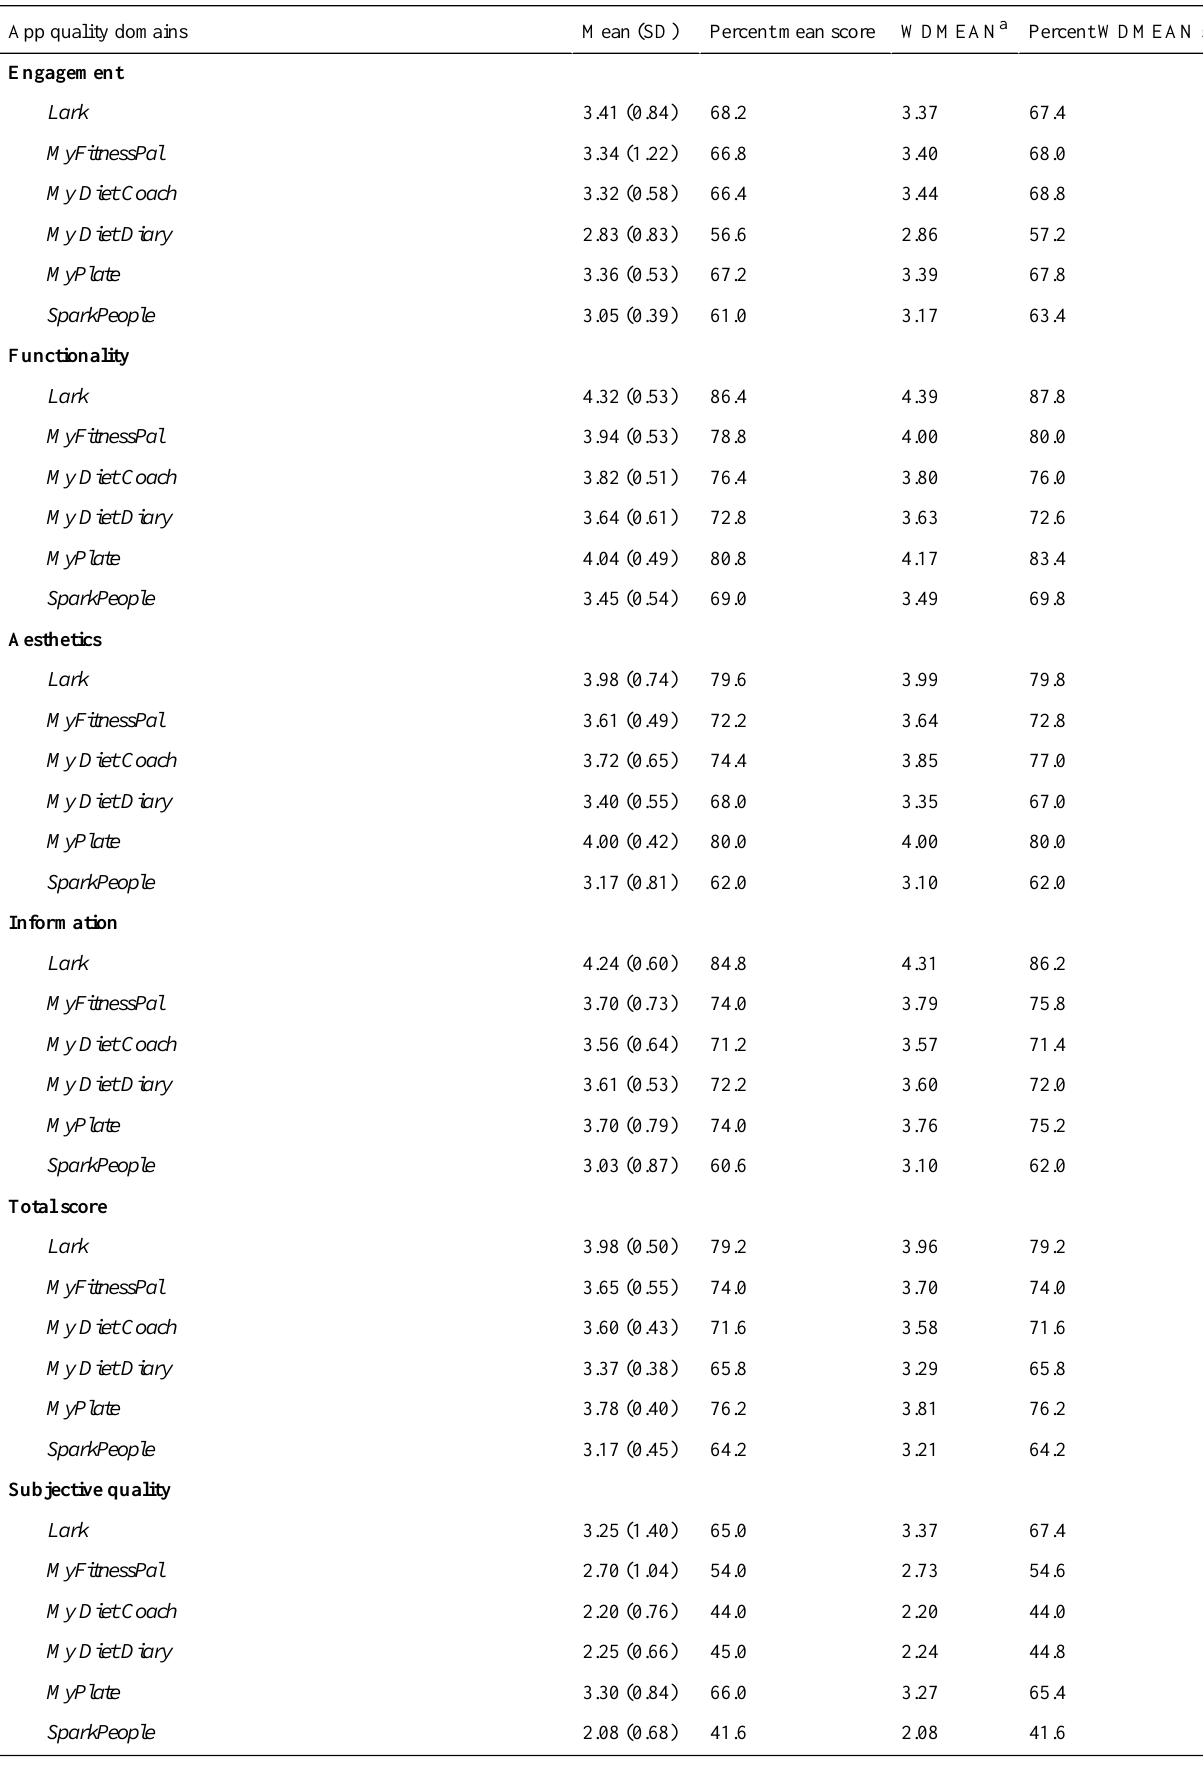
Table 3. Comparison of user-based unweighted and weighted user version of the Mobile App Rating Scale